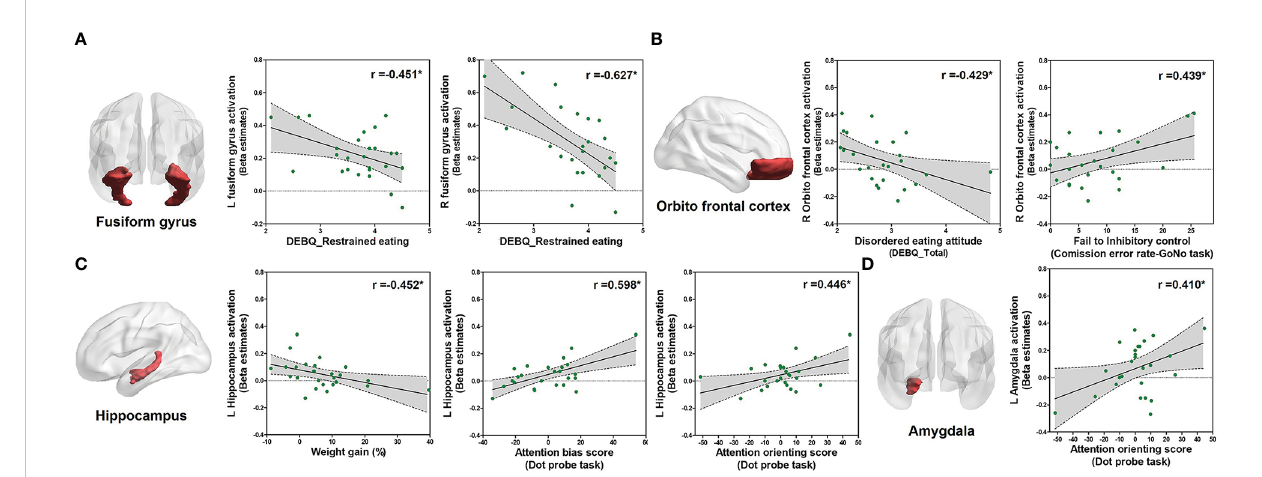
FIGURE 5 Correlation analysis within the HD group. Correlations between eating behavior and the parameter of estimated beta value of ROIs within patients with HD ( n = 29) using Pearson product-moment correlation coef fi cient (two-tailed, P < 0.05). The Y -axis means the activation level of each ROI in food > object contrast. (A) Correlation between the restrained eating score and left/right fusiform gyrus activation. (B) Correlation between the disordered eating attitude (DEBQ total score) and inhibitory control with activation of the right OFC. (C) Correlation between the weight gain and attention scores from the dot-probe scores with left hippocampus activation. (D) Correlation between attention and activation of the left